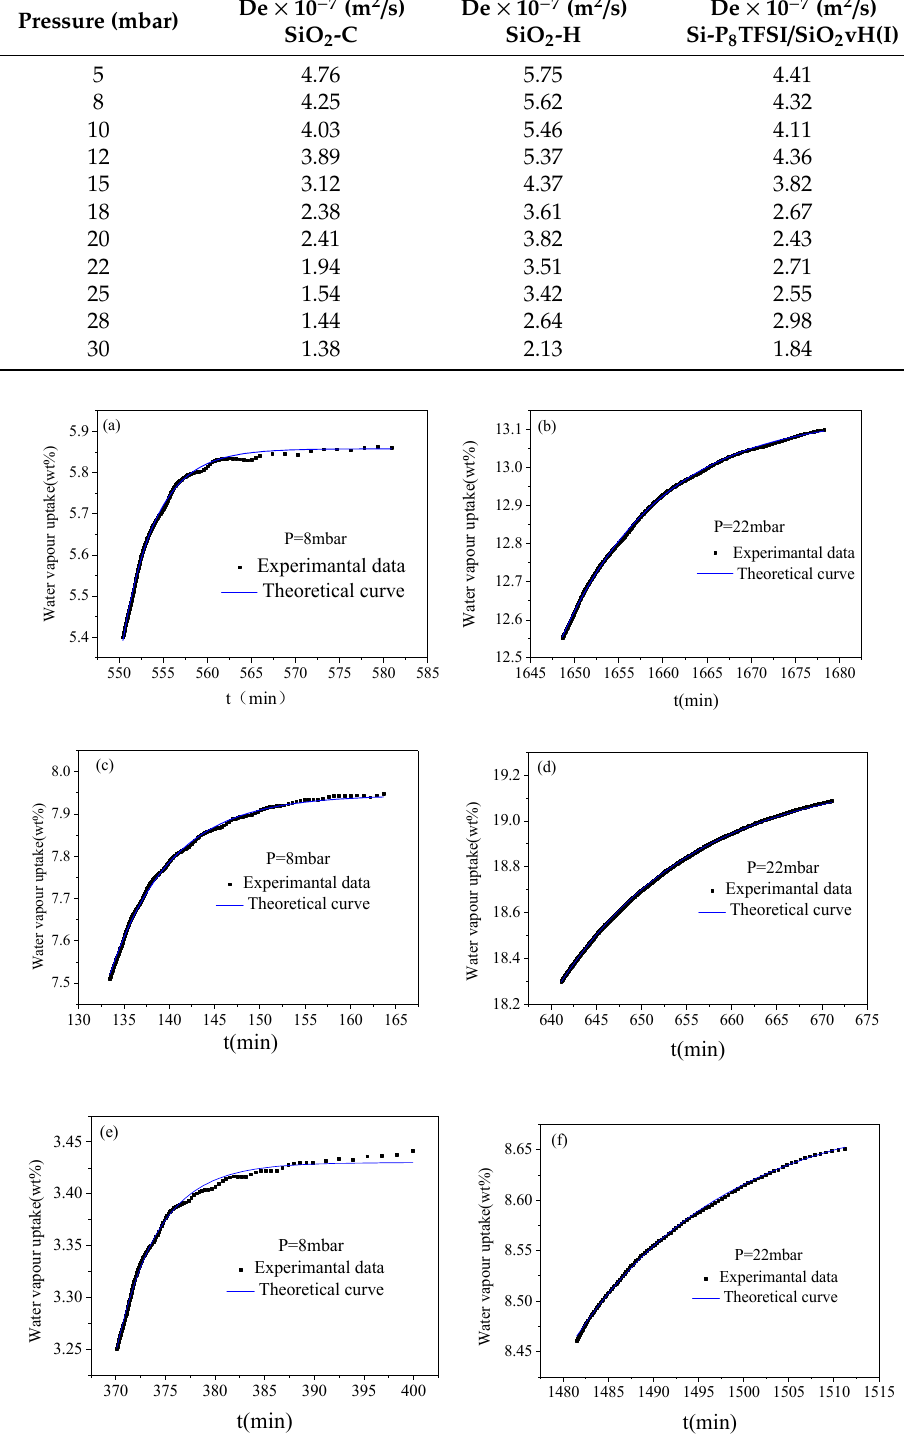
Figure 8. The experimental curves at 25 °C and the theoretical curves, according to Equation (6), for SiO 2 -H ( a , b ), SiO 2 -C ( c , d ), and Si-P 8 TFSI/SiO 2 -H(I) ( e , f ).